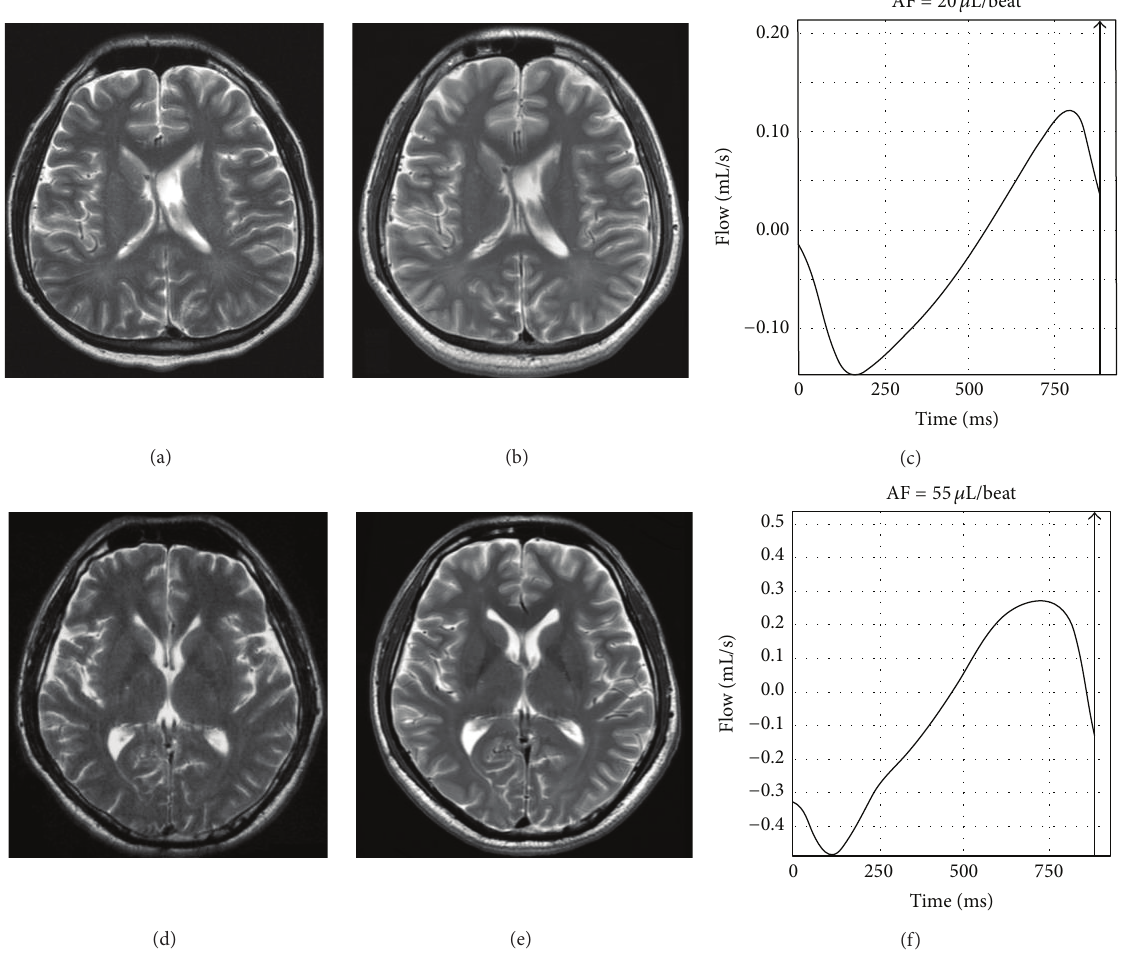
Figure 3: The MR imaging in (a) the acute stage and (b) at follow-up for a 27-year-old male who received a shunt and had a follow-up duration of 98 months showed no interval changes in ventricular size. (c) CSF flow patterns at follow-up showed normal wave form but a smaller longitudinal scale. The MR imaging in (d) the acute stage and (e) at follow-up for a 45-year-old male without a shunt procedure and with a follow-up duration of 97 months showed a mildly increased ventricular size. His CSF flow pattern (f) shows a more extremely increased AF than that of either the controls or the patients without